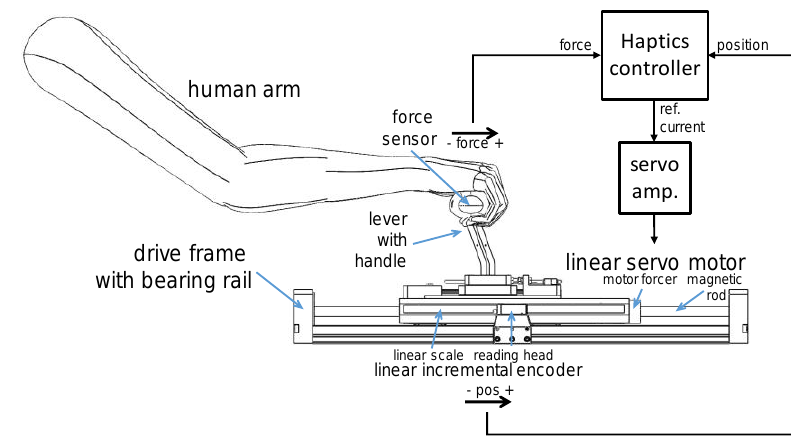
Figure 11. The experimental haptic interface connection scheme.